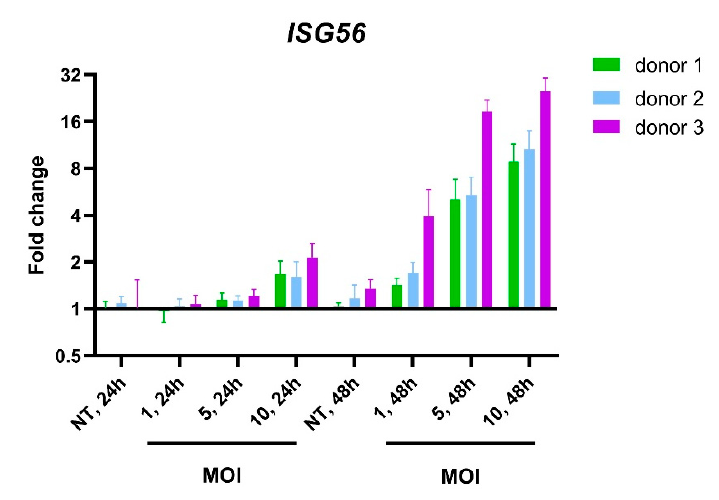
Figure A7. Upregulation of ISG56 in PBMCs incubated with live TBEV. Changes in gene expression following 24 or 48 h incubation with different multiplicities of infection (MOIs) of live virus were analyzed by RT-qPCR in PBMCs from 3 healthy donors.